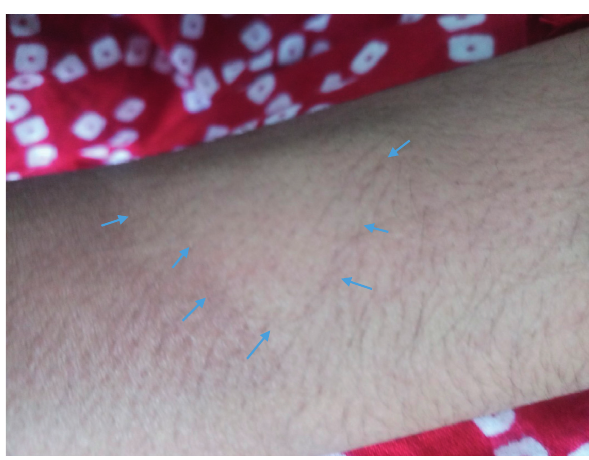
Figure 3: Dermoscopic appearance of forearm.